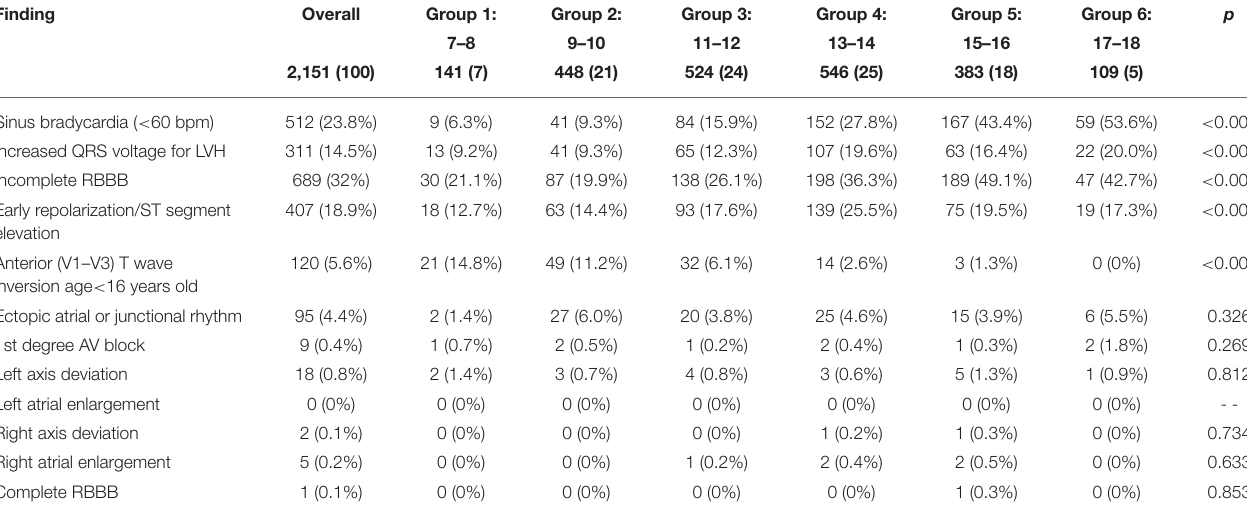
TABLE 3 | Prevalence of training-related ECG findings or borderline findings in the study population per age